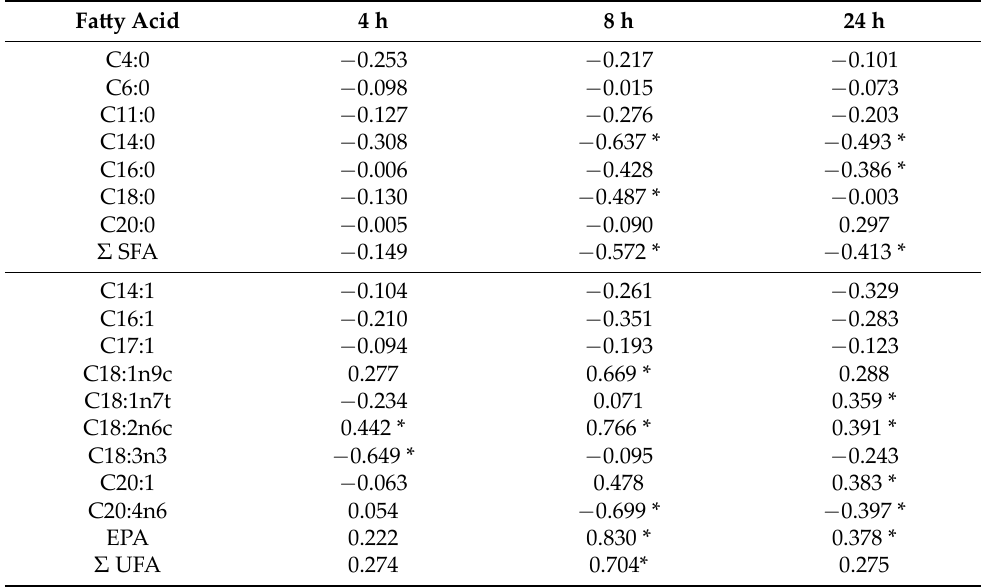
Table 4. Pearson correlation coefficients between fatty acids and DDGS